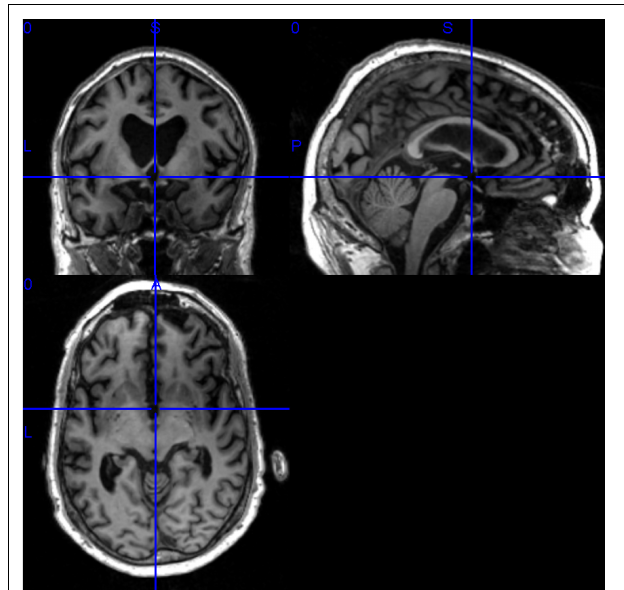
FIGURE 7 | Example of 3D MRI image.